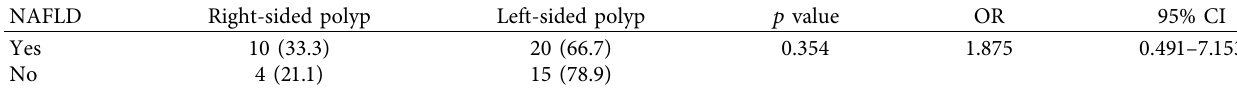
Table 5: Association between NAFLD and polyps’ location ( n � 49).